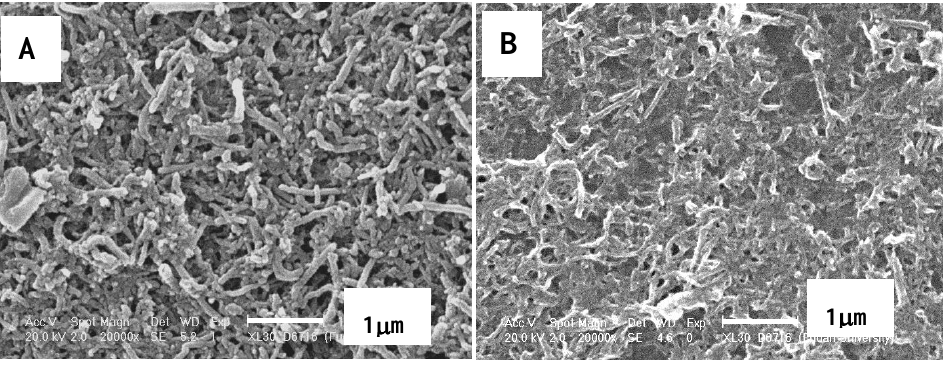
Fe(CN) at bare GCE (A); MWNTs/GCE (B); 3 6